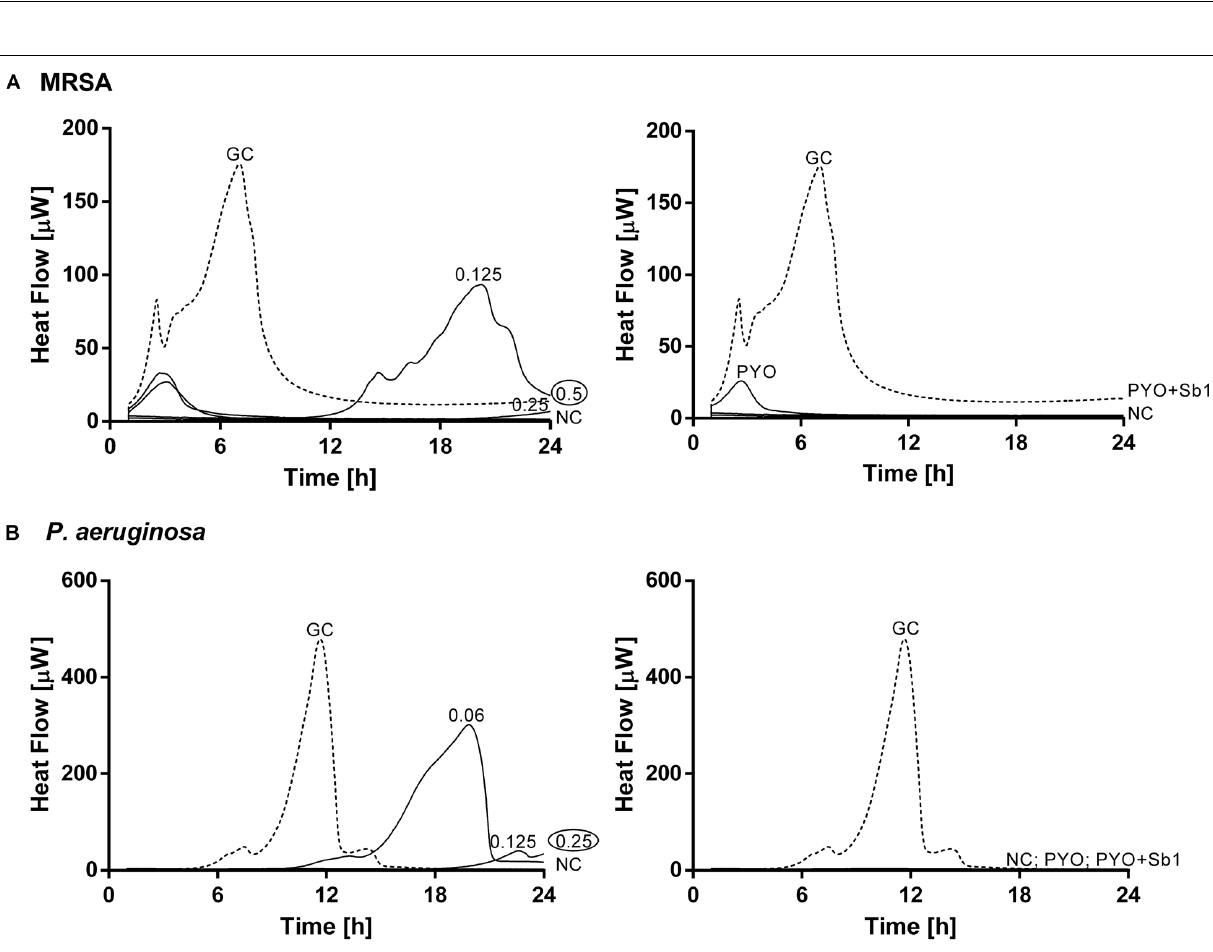
Frontiers in Microbiology |